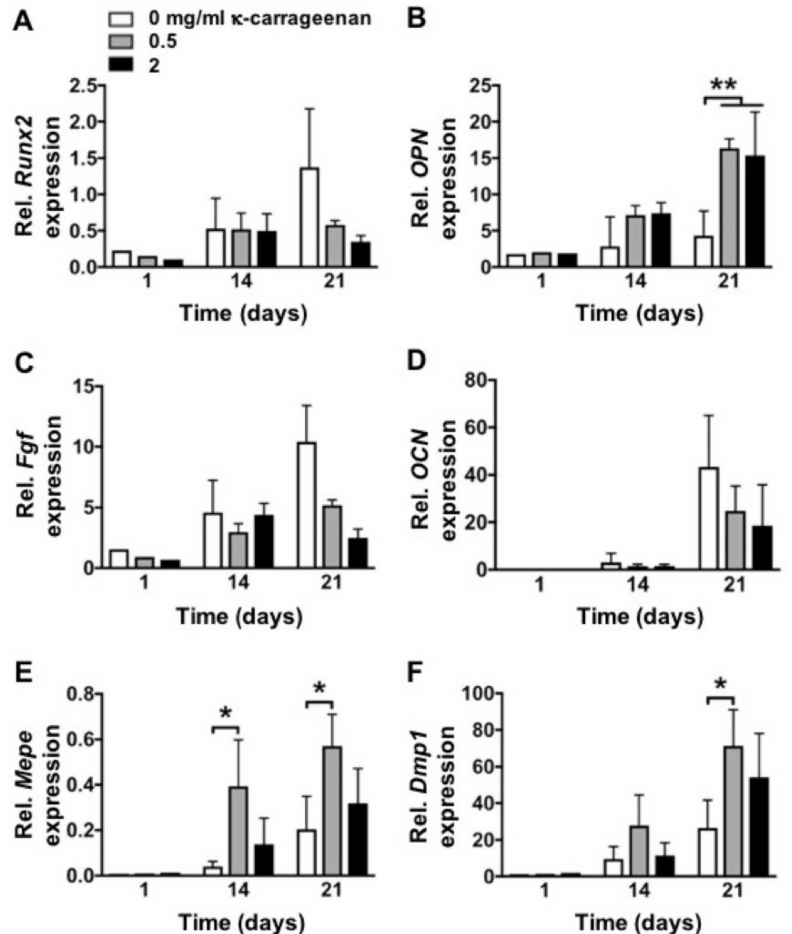
Figure 6. K-Carrageenan enhanced expression of osteogenic markers in MC3T3-E1 pre-osteoblasts at day 1, 14, and 21. Expression pattern of ( A ) Runx2 , ( B ) Opn , ( C ) Fgf2 , ( D ) Ocn , ( E ) Mepe , and ( F ) Dmp1 . Values are mean ± SD from three independent experiments. Significant effect of κ -carrageenan, * p < 0.05, ** p < 0.01.